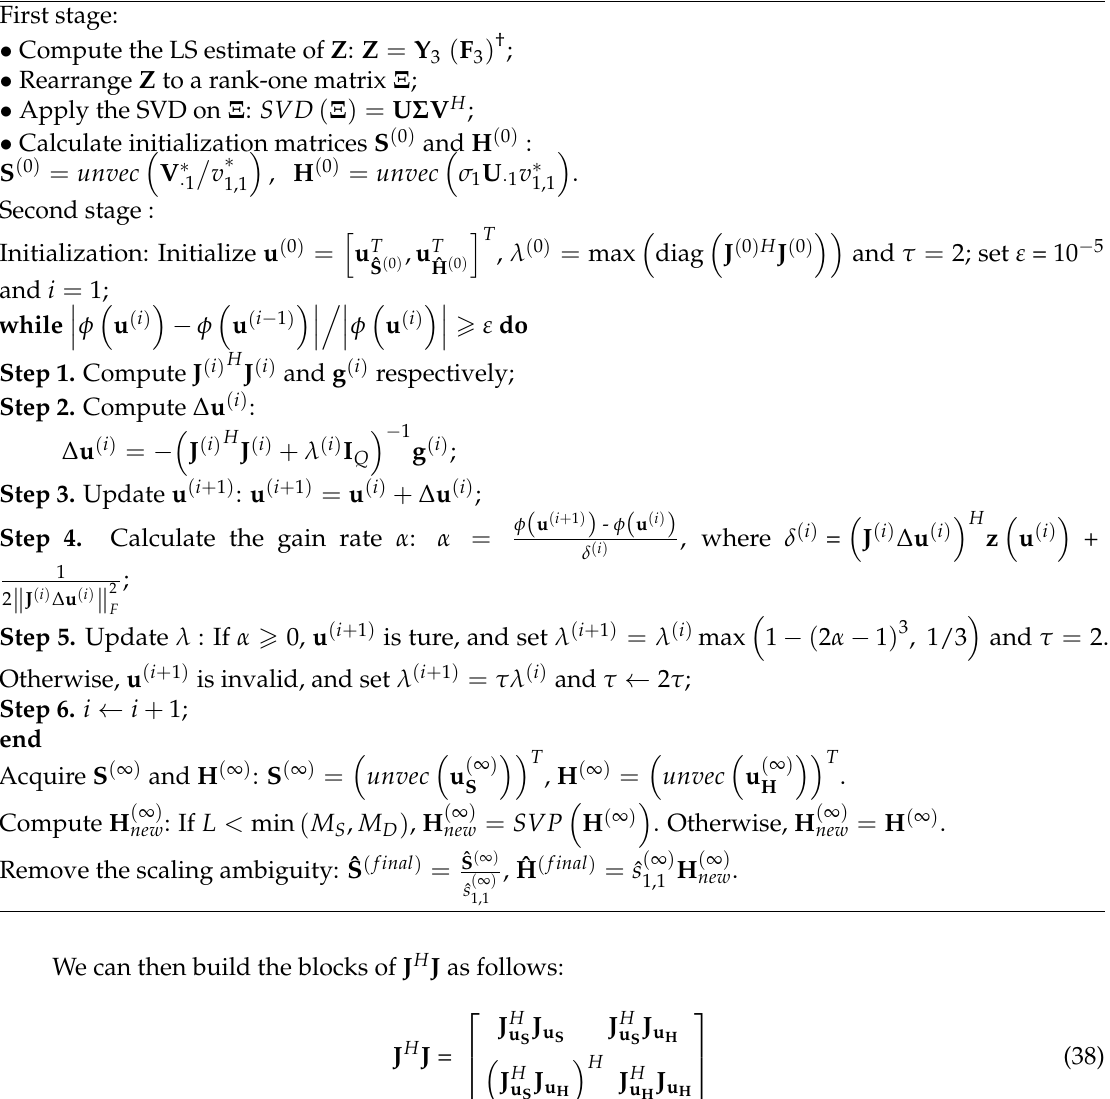
Algorithm 1 The optimized LM